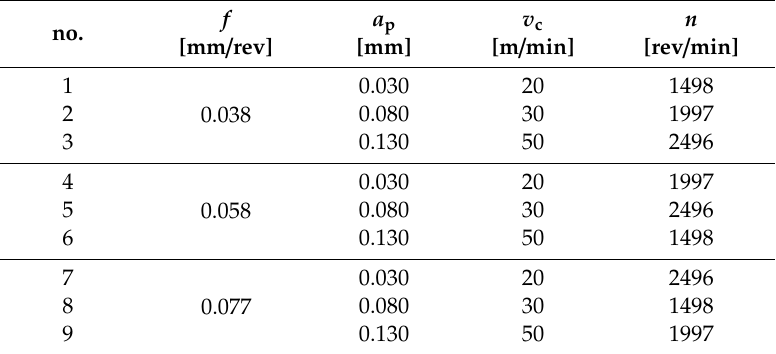
Table 1. Values of the parameters, a p , and n